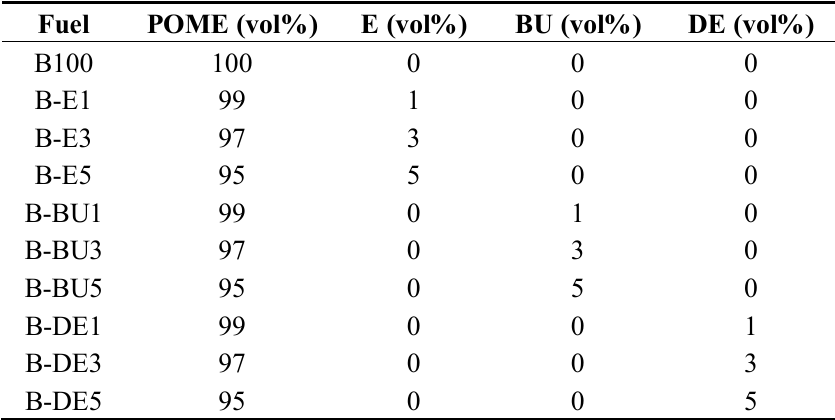
Table 2. Types of blended